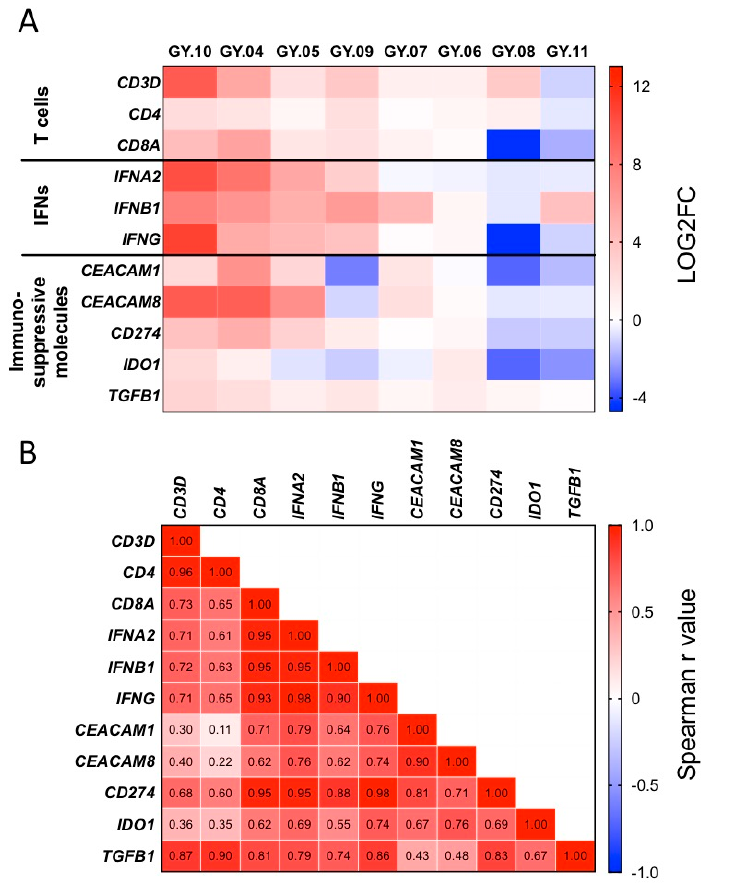
Figure 4. NanoString analysis of primary vs. recurrent tumor samples. ( A ) Heatmap showing the log2 fold change values of the expression of selected genes from the primary and recurrent tumor samples analyzed with NanoString technology. Red indicates high expression and blue indicates low expression. ( B ) Spearman correlation matrix with r values. Red indicates a strong positive correlation, blue indicates a strong negative correlation and white indicates no correlation.